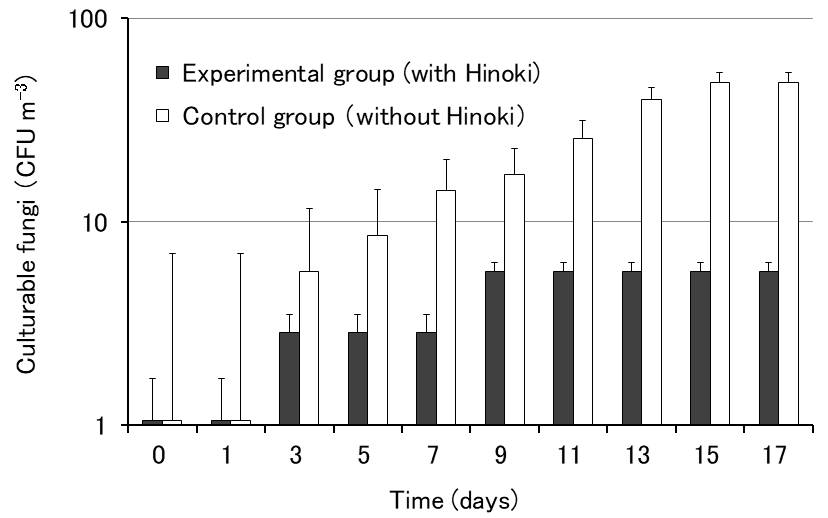
Figure 3. Growth of airborne fungi on potato dextrose agar with and without Hinoki. Each bar represents the mean of five agar plates. The error bars indicate standard errors.